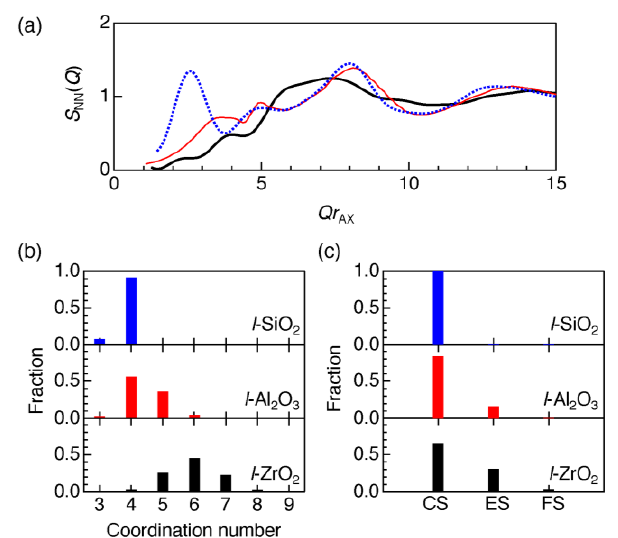
Figure 3. ( a ) Bhatia-Thornton number-number partial structure factor S NN (Q) for l -ZrO 2 at 2800 ◦ C derived from the DFT-MD simulation (bold black curve) [7] in comparison with those for l -Al 2 O 3 at 2127 ◦ C (solid red curve) [5] and l -SiO 2 at 2100 ◦ C (dotted blue curve) [10]. The momentum transfer Q was scaled by r AX ( r AX is the first coordination distance between A and X in the real-space function) to eliminate the effect of the size of cations. ( b ) Coordination number distribution of oxygen around the cations in l -ZrO 2 at 2800 ◦ C [7], l -Al 2 O 3 at 2127 ◦ C [5] and l -SiO 2 at 2100 ◦ C [10]. ( c ) Polyhedral connections in l -ZrO 2 at 2800 ◦ C [7], l -Al 2 O 3 at 2127 ◦ C [5] and l -SiO 2 at 2100 ◦ C [10]. CS: corner sharing of oxygen; ES: edge sharing of oxygen; FS: face sharing of oxygen.